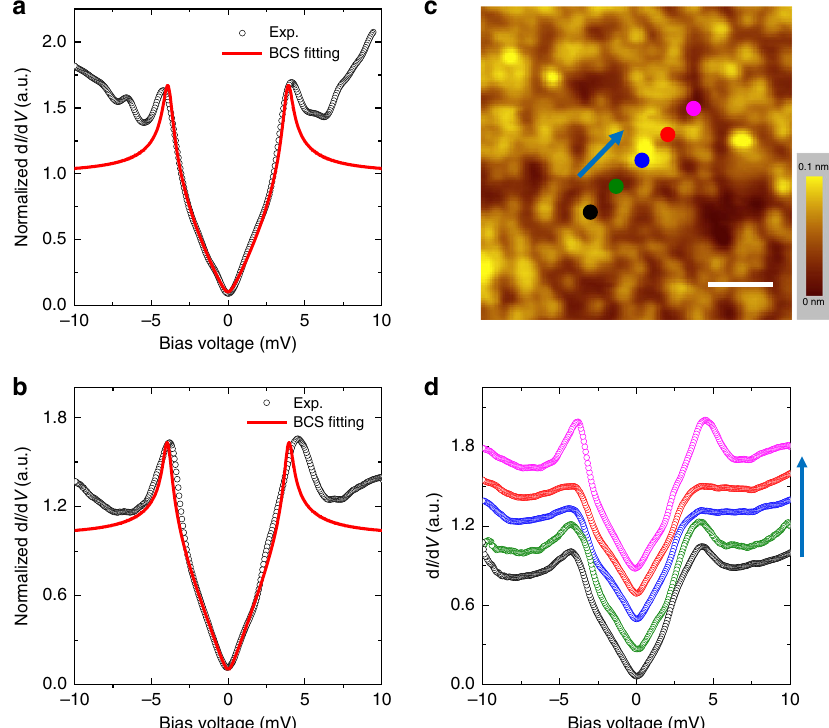
Fig. 2 Tunneling spectra with a V-shape. a A tunneling spectrum with a V-shape (black circles), which is measured at the surface with large roughness after post-annealing. The Dynes model fi tting (red solid curve) yields a gap function Δ = 3.9cos2 θ (meV). b A typical V-shape spectrum (black circles) measured at the surface with much smaller roughness after a long time vacuum annealing. A gap function Δ = 3.95(0.95cos2 θ + 0.05cos6 θ ) (meV) is used in the fi tting (red solid curve). c Topographic image with much smaller roughness. Scale bar = 2 nm. d Five spectra measured on the fi ve spots shown in c . Setting condition for a is V bias = 10 mV, I t = 100 pA, for b , d is V bias = 4 mV, I t = 100 pA and for c is V bias = 0.36 V, I t = 50 pA.